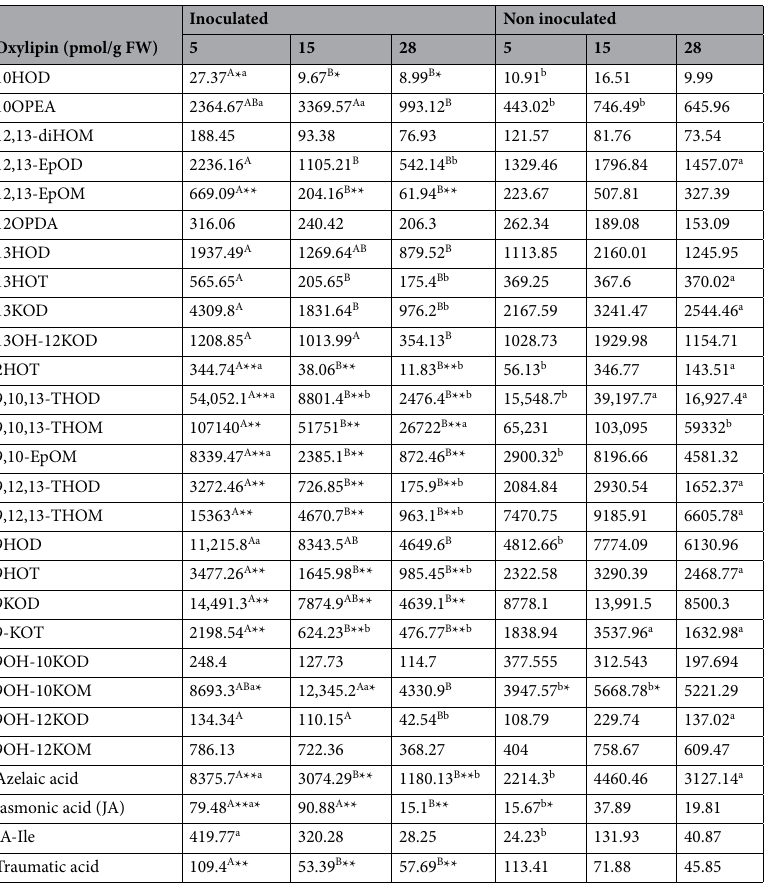
Table 1. Summary of oxylipin concentrations in tomato roots that were or were not inoculated with M. javanica , at different time points (5, 15 and 28 DAI). Data were analyzed by one-way ANOVA ( p < 0.05), and compared by Student t-test to test for significant differences between inoculated and noninoculated values at the same time point, and Tukey HSD test for statistical significance between different time points for the same treatment. Uppercase letters refer to significant differences between means of the different time points in the same treatment; lowercase letters refer to significant differences between means of the same time point in different treatments. * p < 0.0001, ** p <